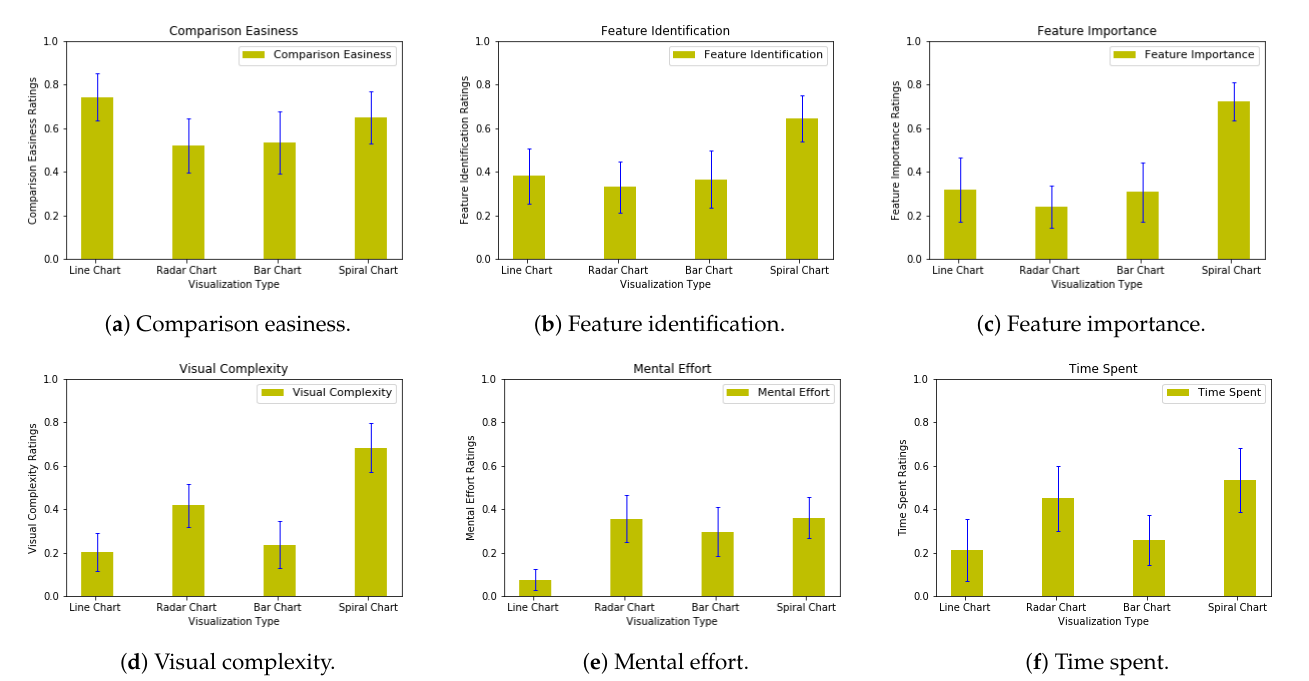
Figure 9. Comparison of mean normalized metrics for different visualisation types.